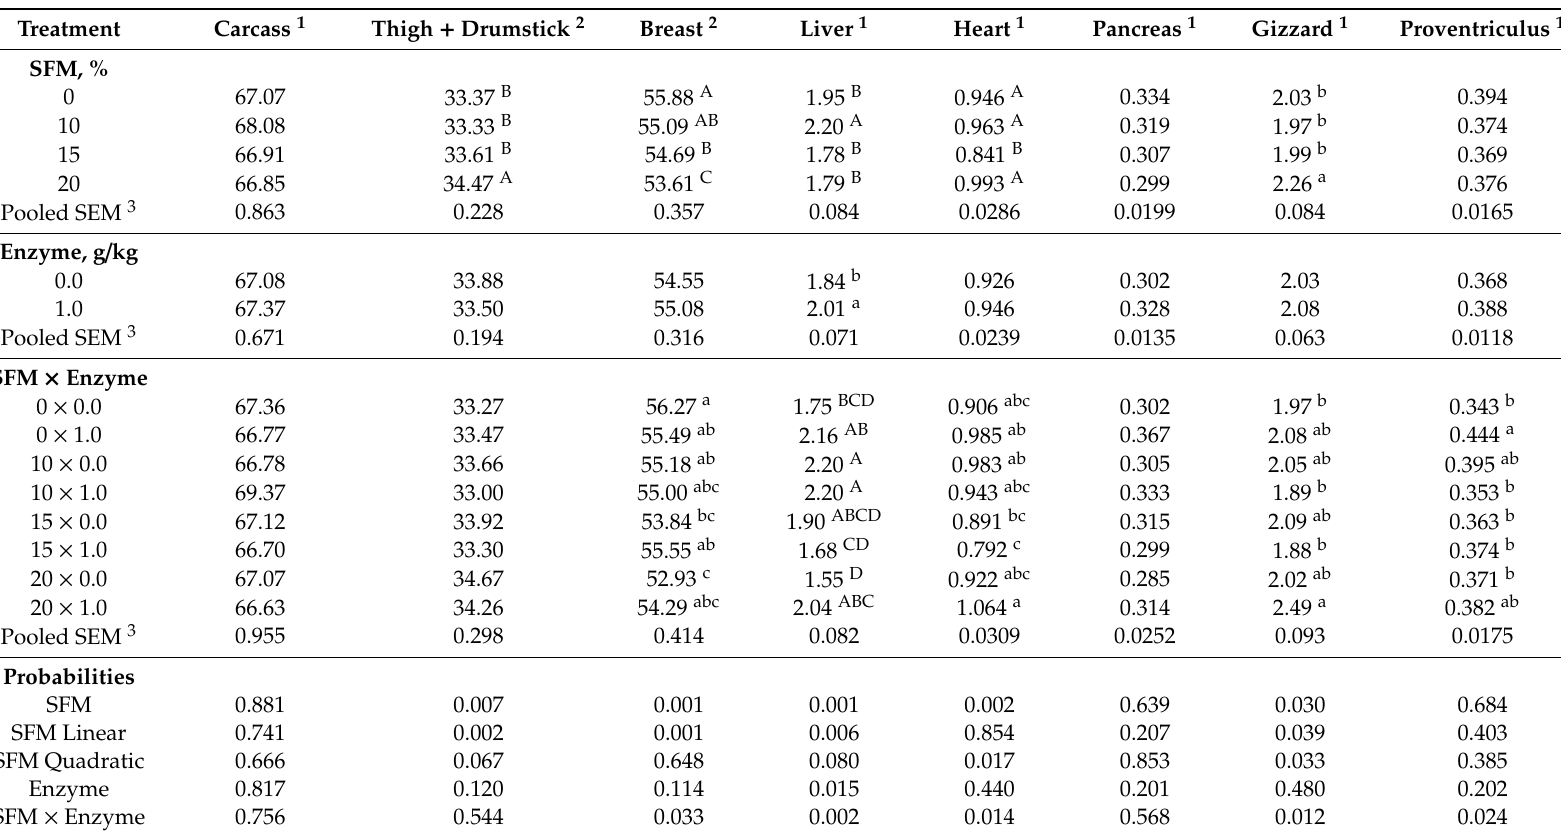
Table 3. Influence of supplemental SFM levels and multi-enzyme addition in the diet on the meat yield and some relative organ weights in growing quails *.